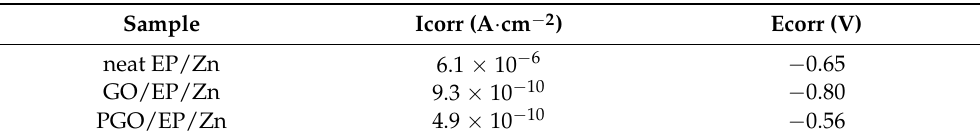
Figure 7. Tafel curves of EP/Zn coatings modified with GO and PGO in 3.5 wt.% NaCl solution. Table 2. Icorr and Ecorr of neat EP/Zn, GO/EP/Zn and PGO/EP/Zn coating with different GO contents in 3.5 wt.% NaCl solution.